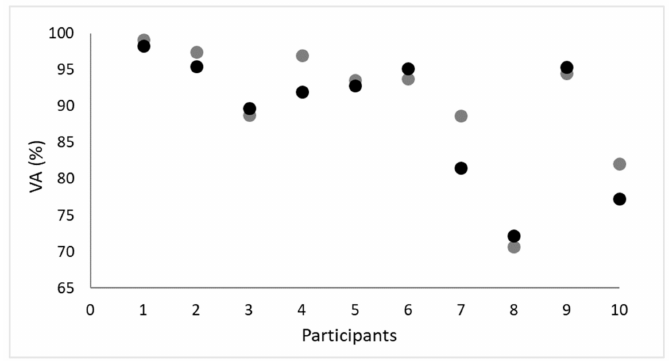
Figure 2. VA (voluntary activation) of the quadriceps muscle for all 10 participants (paired electrical stimuli were used during the ITT, grey circles; triple electrical stimuli were used during the ITT; black